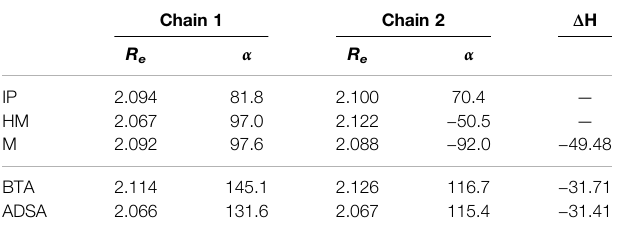
TABLE 2 | S-S bond length ( R e ), in Å, R-SS-R dihedral angle ( α ), in degrees, and interaction energy ( Δ H), in kcal/mol, between two polymeric chains. Chain 1 Chain